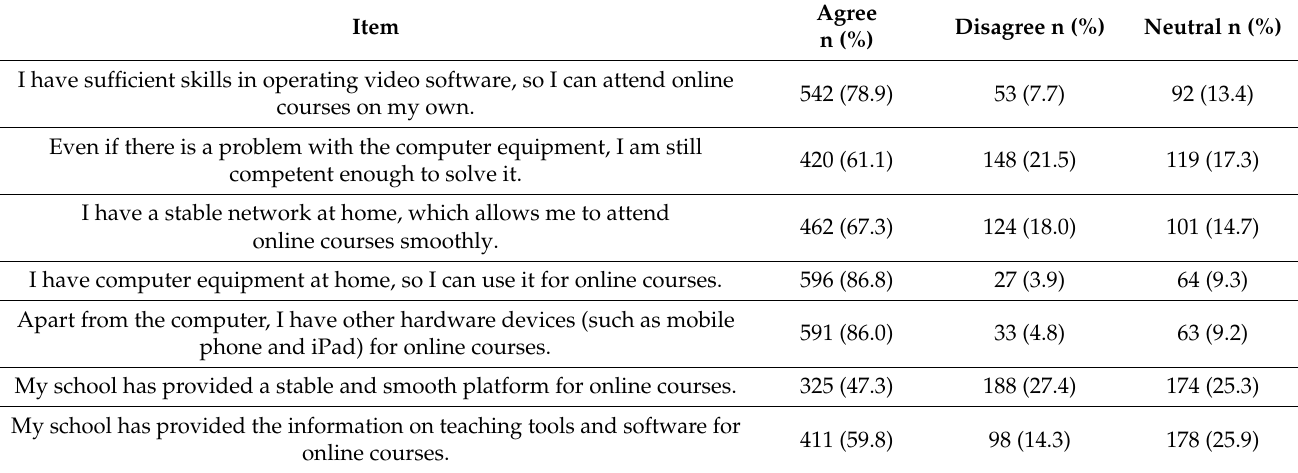
Table 3. Computer equipment and operation skills (n = 687).